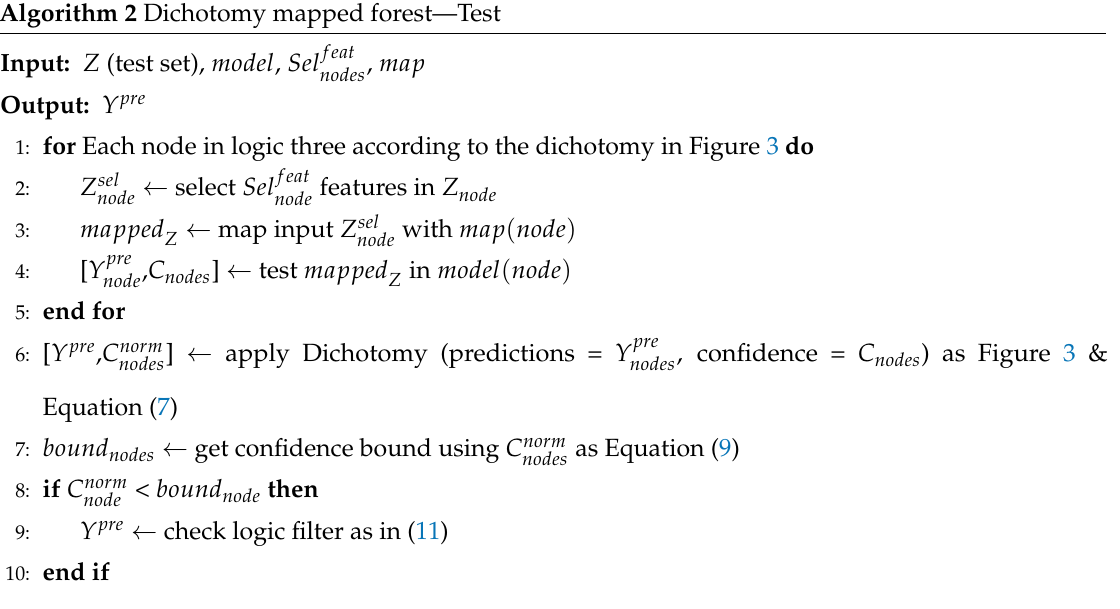
Algorithm 2 Dichotomy mapped